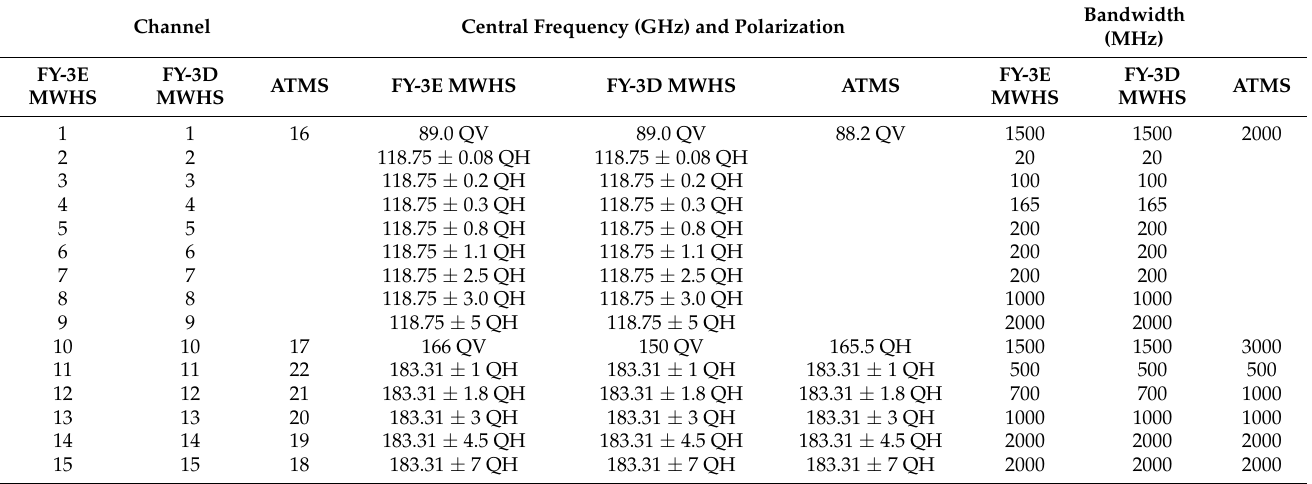
Table 1. Comparison of basic characteristics between FY-3E MWHS-II, FY-3D MWHS-II and ATMS. Channel Central Frequency (GHz) and